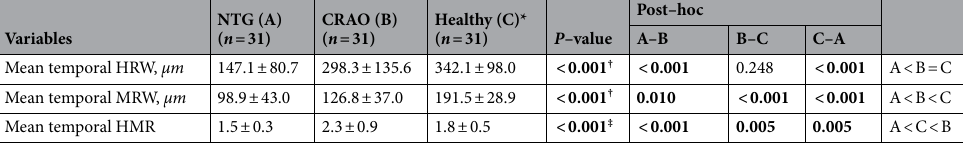
Table 3. Comparison of neuroretinal rim widths in the temporal area between the groups ( n = 93). Values are shown in mean ± standard deviation, with statistically significant P –values in boldface. NTG normal tension glaucoma, CRAO central retinal artery occlusion, HRW horizontal rim width, MRW minimum rim width, HMR horizontal-to-minimum rim width ratio. *Healthy fellow eyes of CRAO subjects. Comparison was performed using ANOVA † and Kruskal–Wallis ‡